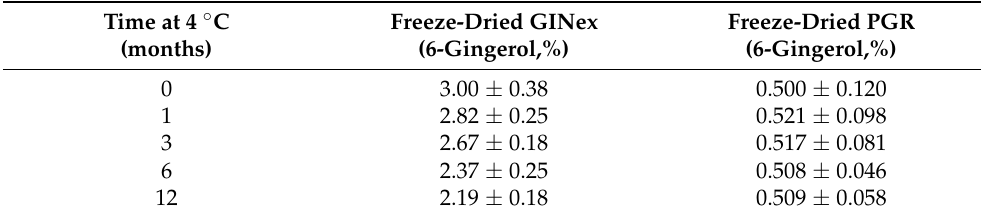
Table 6. Residual drug loading of PHYTOGINROSA (PGR) 0.5:0.5:1 compared to ginger extract (GINex) for 1 year of storage.